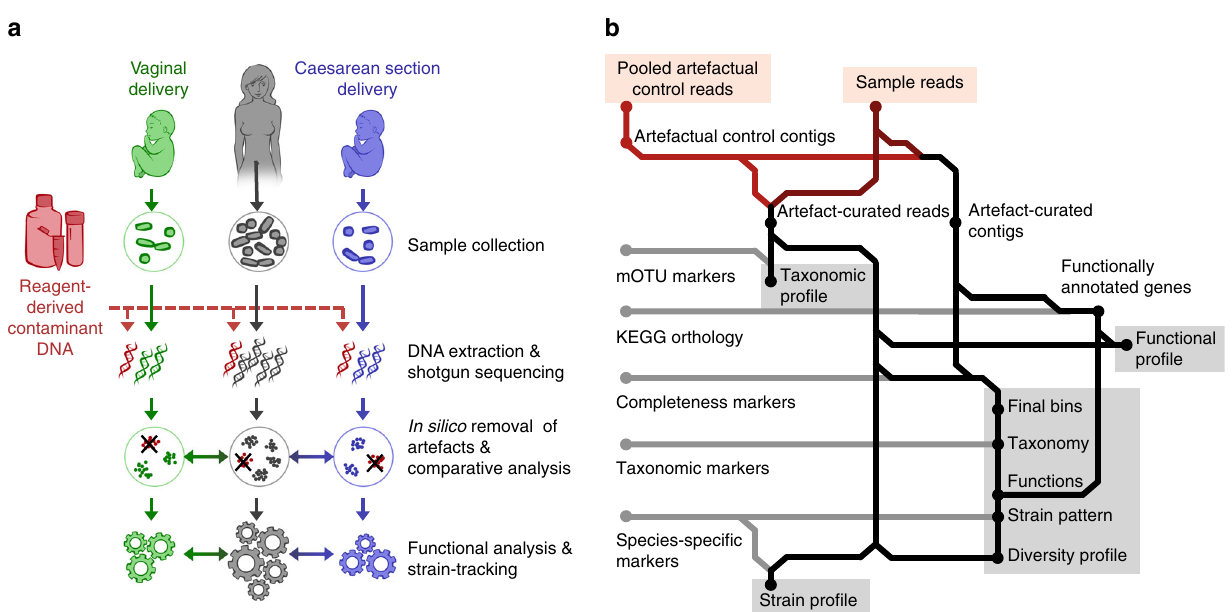
Fig. 1 Curation of metagenomic data. a Schematic representation of the work fl ow for removal of artefacts introduced during genomic extraction or preparation of sequence libraries in the low-biomass neonatal samples. b Sample-wise bioinformatic work fl ow for removal of artefactual sequences from metagenomic data, extraction of taxonomic and functional pro fi les, and reconstruction of genomes and strain-resolved analyses. The resulting data sets used for inter-sample comparisons are highlighted in grey. mOTU, metagenomic operational taxonomic